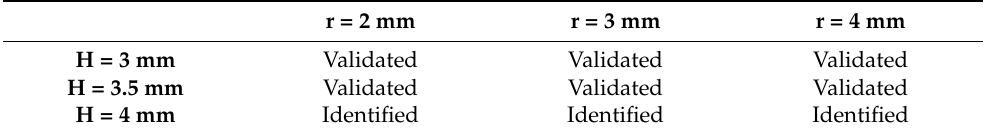
Figure 13. Matrix of plots showing the comparison among experimental (depicted in black) and simulated (depicted in red) curves, for different dome geometries. Table 1. Experimental dataset splitting.